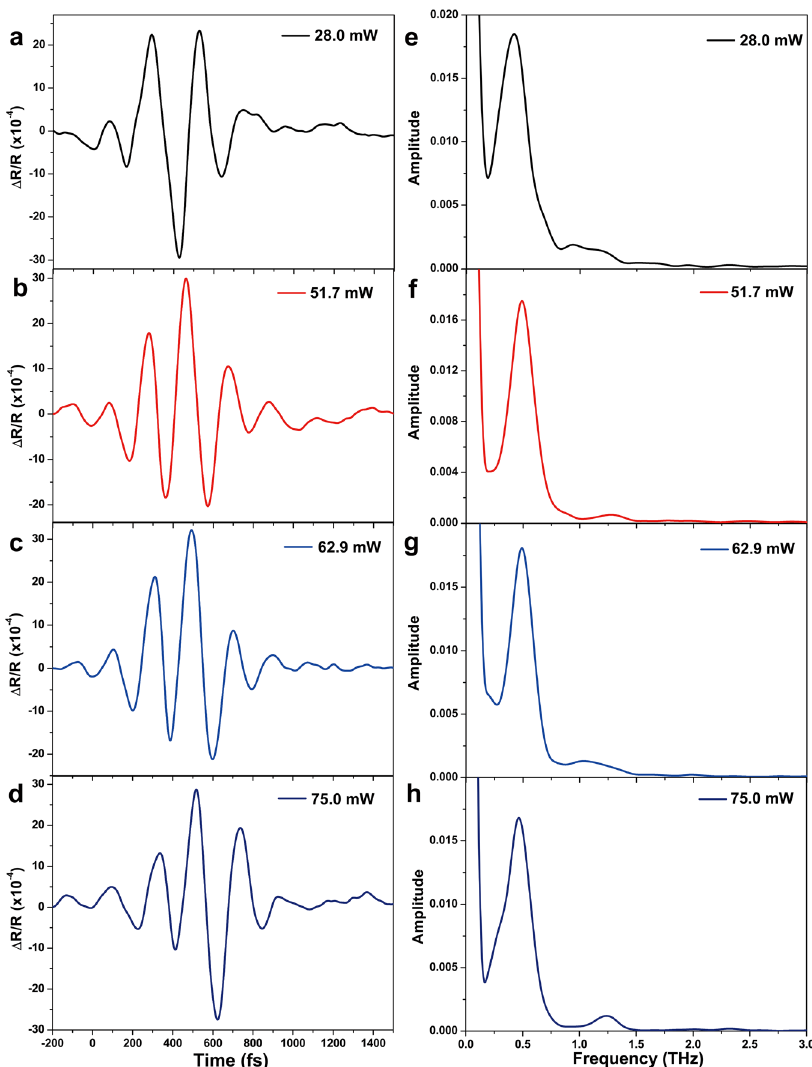
Fig. 3 Transient differential re fl ectivity and corresponding fast Fourier transform (FFT) spectra with femtosecond high-power pump at 710 nm. a – d Transient differential re fl ectivity ( Δ R/R) and e – h corresponding FFT spectra with pump power 28.0 mW ( a , e ), 51.7 mW ( b , f ), 62.9 mW ( c , g ), 75.0 mW ( d , h